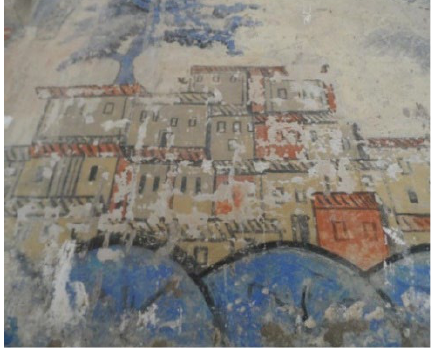
Figure 1. Examples of lacunae deterioration on the mural.